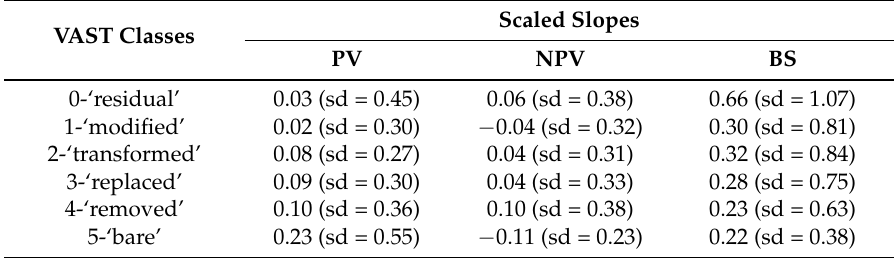
Table 9. Vegetation Assets, States and Transitions (VAST) classification comparison with inter-annual trends for scaled components of fractional cover. sd—standard deviation. VAST